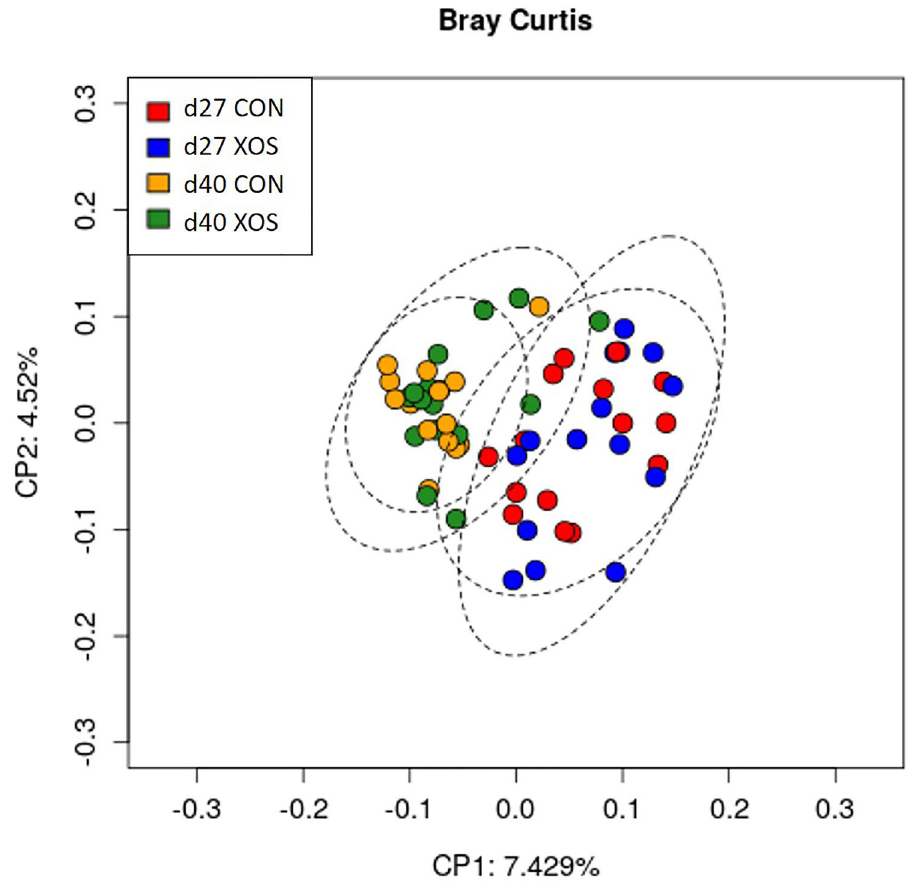
Figure 1. Principal coordinate analysis (PCoA) ordination performed by Bray–Curtis dissimilarities representing the microbiome composition for all animals. d27 CON (red): fecal samples of piglets supplemented with water on day 27; d27 XOS (blue): fecal samples of piglets supplemented with XOS on day 27; d40 CON (yellow): fecal samples of piglets supplemented with water on d40; and d40 XOS (green): fecal samples of piglets supplemented with XOS on